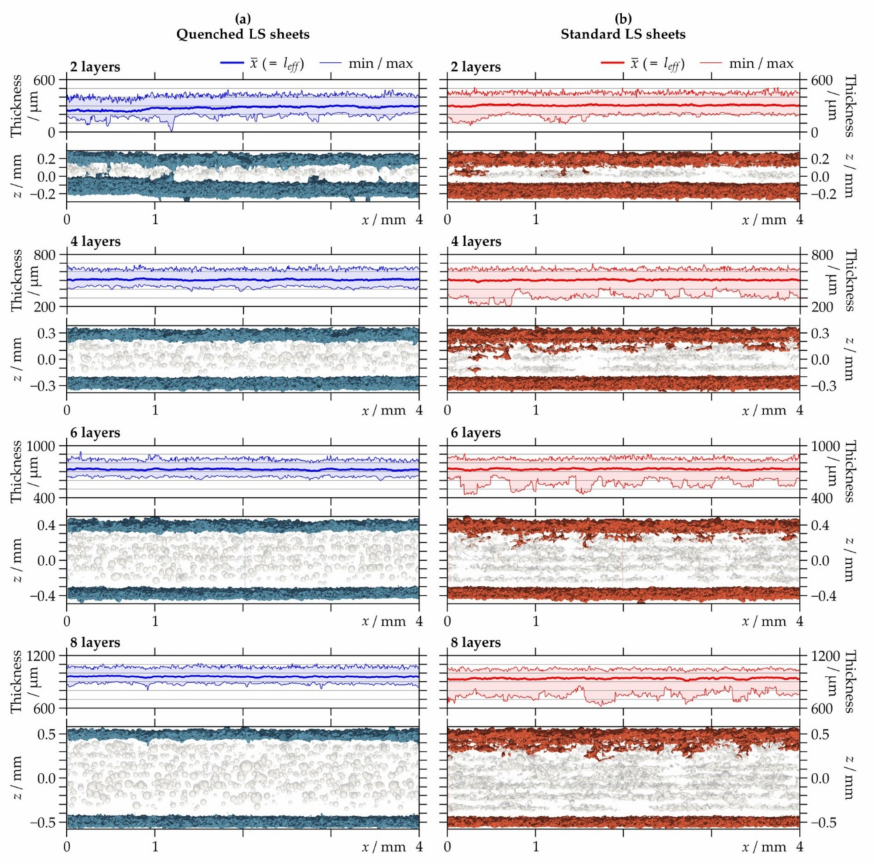
Figure 8. Semi-transparent view of visualized X-ray micro-computed tomography data through 4 mm (= 1000 voxels) cross-sections and projected thickness distribution with average, minimal, and maximal values of ( a ) quenched and ( b ) standard laser-sintered (LS) polyamide 12 sheets generated with two, four, six, and eight layers. The projected surface contours of the LS sheets are blue (quenched LS sheets) and red (standard LS sheets). The closed pores are shown in light gray.